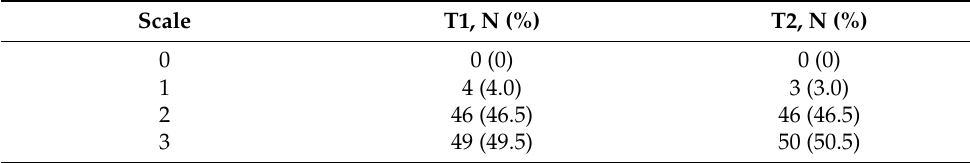
Figure 2. Bland-Altman analysis of RGV taken in supine and RLD positions. The y -axis represents the difference between RGV in supine and RLD. The x-axis represents the mean between RGV in supine and RLD. The dashed lines are the upper (UAL) and lower limits (LAL) of a 95% agreement band (mean ± 2 SD). The solid line represents the mean difference or bias of the RGV. There was no significant difference between parental satisfaction during T 1 and T 2, as shown in Table 3. Table 3. Parental satisfaction scale concerning clear fluid fasting time.